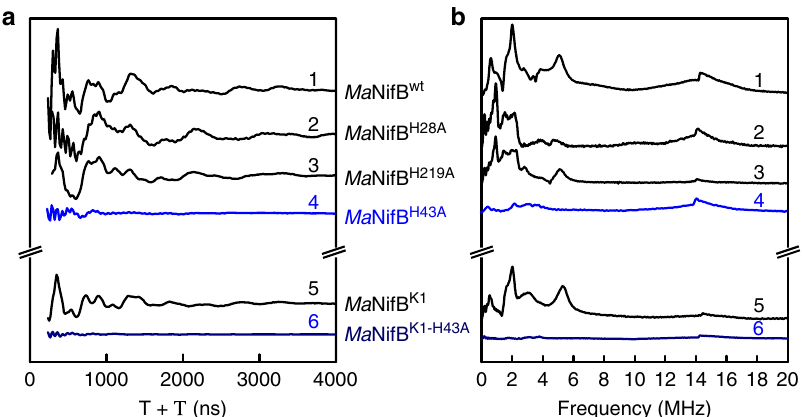
Fig. 1 Three-pulse ESEEM spectra of dithionite-reduced Ma NifB proteins. a Time domain and ( b ) fast Fourier transformed (FFT) spectra of Ma NifB wt (1), Ma NifB H28A (2), Ma NifB H219A (3), Ma NifB H43A (4), Ma NifB K1 (5) and Ma NifB K1-H43A (6). The time domain spectra of the His-ligand containing samples (i.e., 1, 2, 3, and 5) have modulations from 14 N that appear as peaks in the fast Fourier transformed (FFT) spectra between 1 and 6 MHz. The sharp modulations between 250 and 500 ns in the time domain and the resulting broad peak near 14 MHz in the FFT are from nearby weakly coupled protons. The ESEEM spectra were recorded at 10 K, τ = 128 – 144 ns, π /2 = 12 ns, and 9.3366 GHz. The experiment was performed three times independently ( n = 3 independent samples), and representative results are shown in the fi gure. All protein samples have a concentration of 15 mg mL − 1 . The CW EPR spectra of these dithionite-reduced Ma NifB proteins are shown in Supplementary Fig. 3.